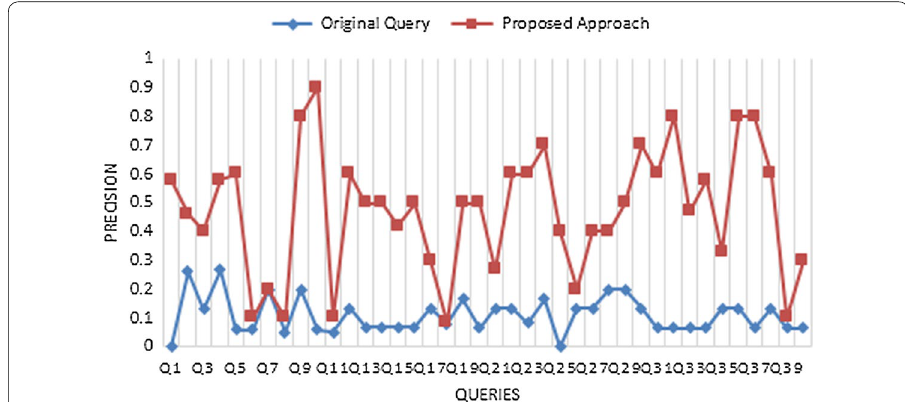
Fig. 3 Accuracy of proposed approach versus queries without expansion